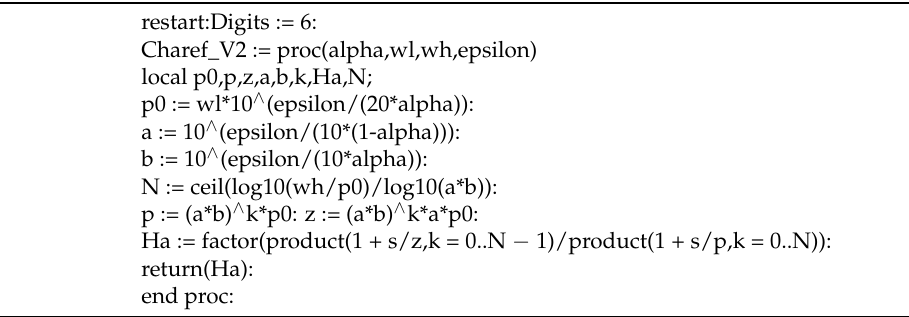
Table 9. Code in Maple 18 environment of